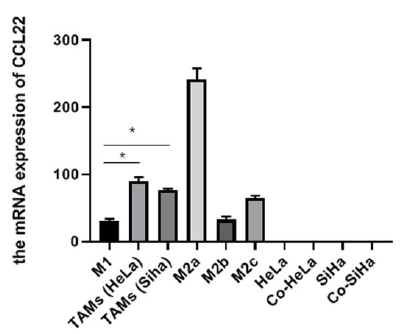
Figure 1. CCL22 expression in TAMs of cervical cancer in vitro. Total RNA was prepared from polarized macrophages (M1, M2a, M2b, M2c), TAMs (tumor-associated macrophages, formed by co-cultured with HeLa or Siha cells), cervical cancer cells HeLa, Siha, co-HeLa, and co-Siha (alone and in co-culture systems). RT-PCR analysis was constructed using CCL22-specific primers. The results are representative of three independent experiments. * Represents p < 0.05.